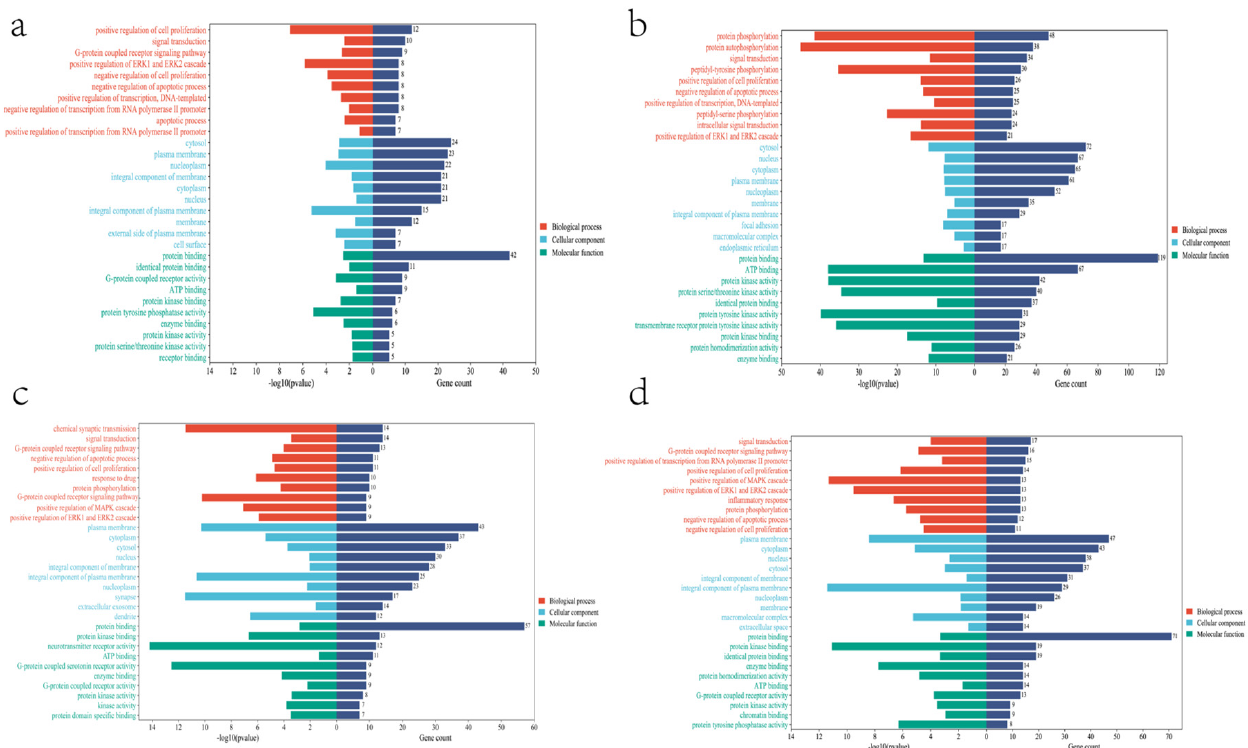
Figure 6. Go enrichment analysis of four components of Tanshinone(( a ): Tanshinone Ir; ( b ): Tanshinone IIA; ( c ): Dihydrotanshinone I; ( d ): Cryptotanshinone).